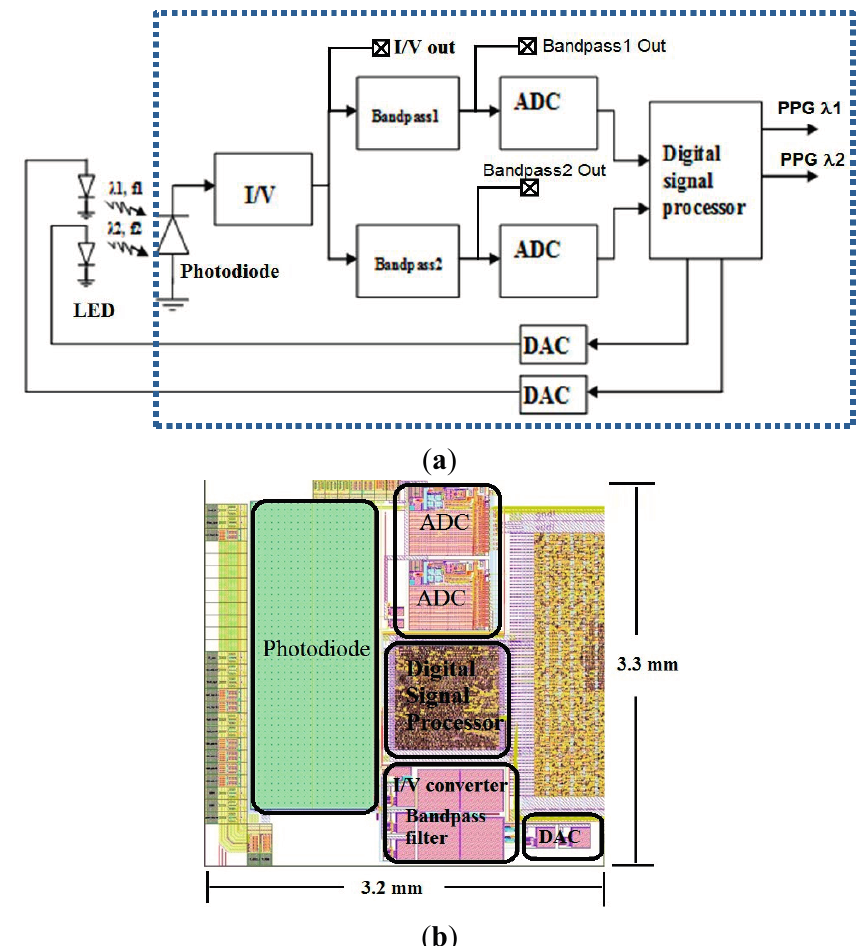
Figure 1. ( a ) Block diagram of the sensor. (Photodiode, I/V—Current to Voltage Converter, ADC—analogue to digital converter, Digital signal processor, DAC—digital to analogue converter, LED—light emitting diode)—Items inside dotted region are all “CMOS on-chip”; ( b ) Layout of the CMOS sensor.